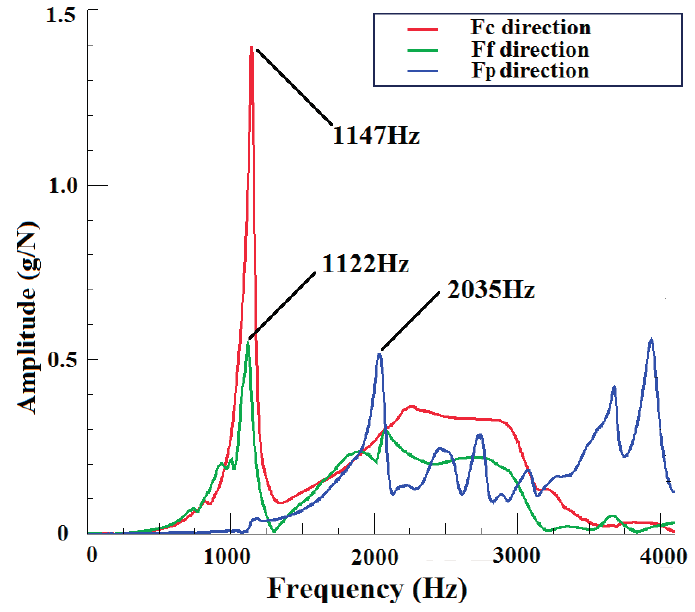
Figure 10. Frequency and amplitude result of impacting modal test.